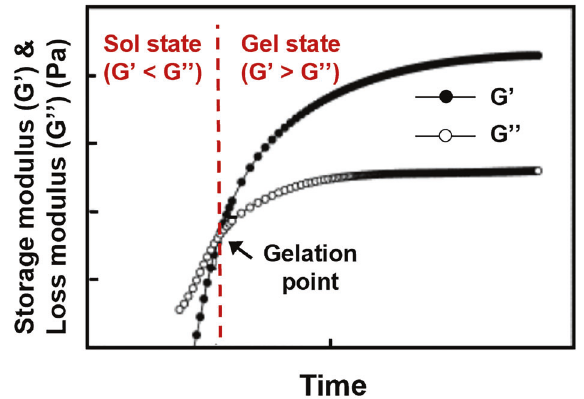
Fig. 2 Rheological characterization of solution to gelation (sol – gel) transition process of hydrogel precursor. Modi fi ed from ref. 71 . Copyright 2006,